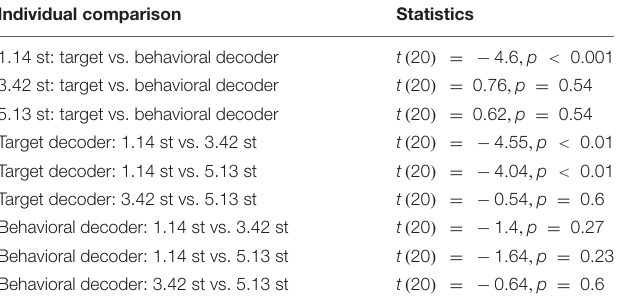
TABLE 3 | Post hoc analyses for the Equation 4